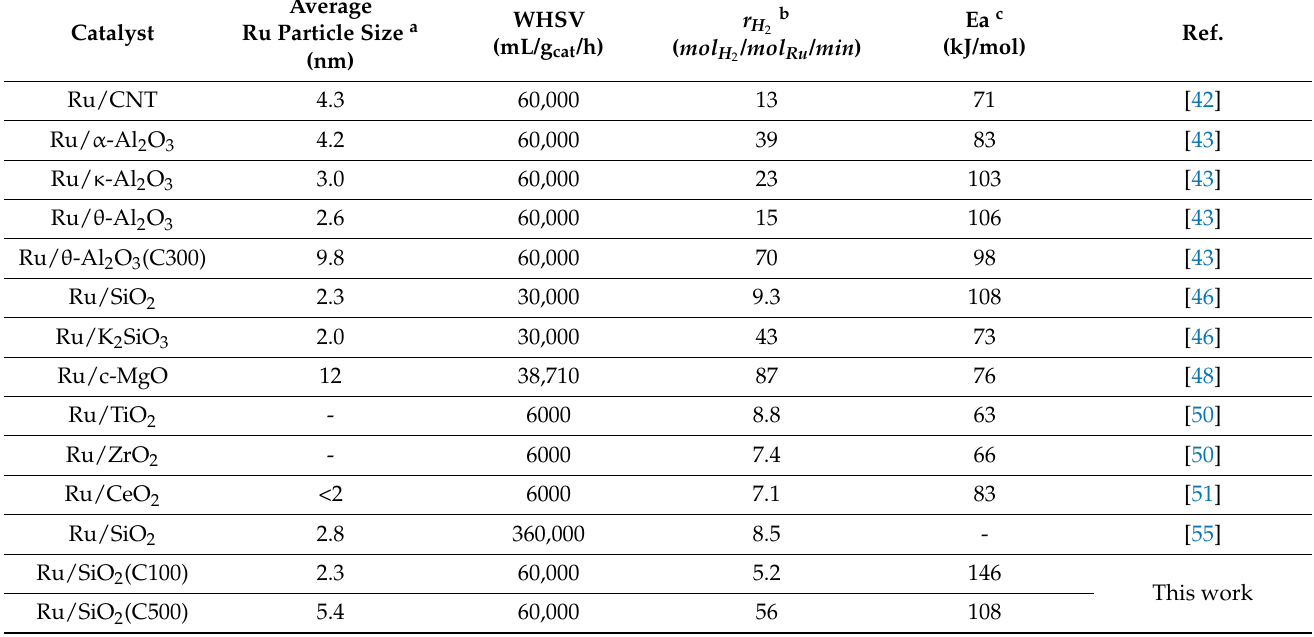
Figure 4. Stability test over Ru/SiO 2 catalysts at 400 ◦ C. ( a ) Ru/SiO 2 (C100) (black), Ru/SiO 2 (SC700) (red), Ru/SiO 2 (SC800) (blue), Ru/SiO 2 (SC900) (green), Ru/SiO 2 (SC930) (pink), Ru/SiO 2 (SC950) (brown). ( b ) Ru/SiO 2 (C100) (black), Ru/SiO 2 (C300) (dark green), Ru/SiO 2 (C500) (dark blue), and Ru/SiO 2 (C700) (dark pink). Reaction conditions: feed composition (25 mol% NH 3 , 70 mol% He, and 5 mol% CH 4 ). Table 2. Comparison of catalytic performance of Ru/Al 2 O 3 and Ru/SiO 2 catalysts for amm- onia